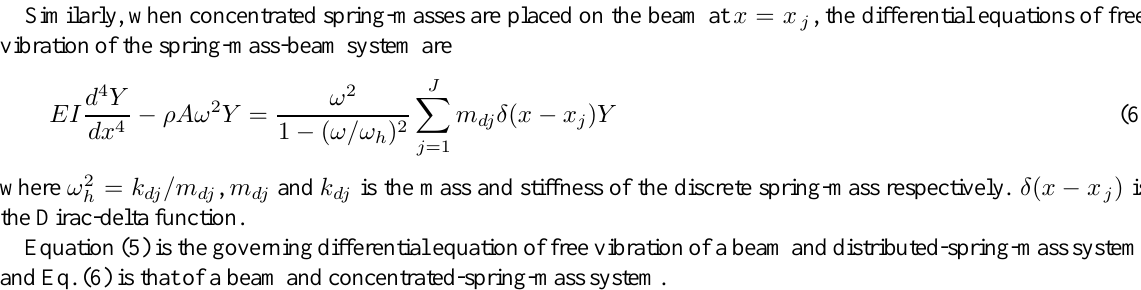
Fig. 1. A spring-mass-beam